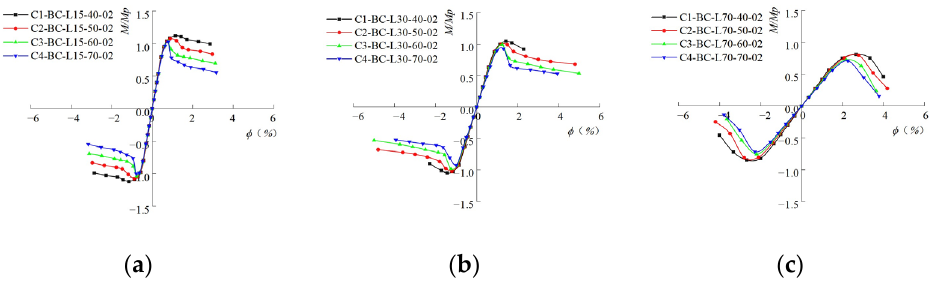
Figure 10. The effect of width-to-thickness ratio. ( a ) λ = 15, n = 0.2; ( b ) λ = 30, n = 0.2; ( c ) λ = 70, n = 0.2.